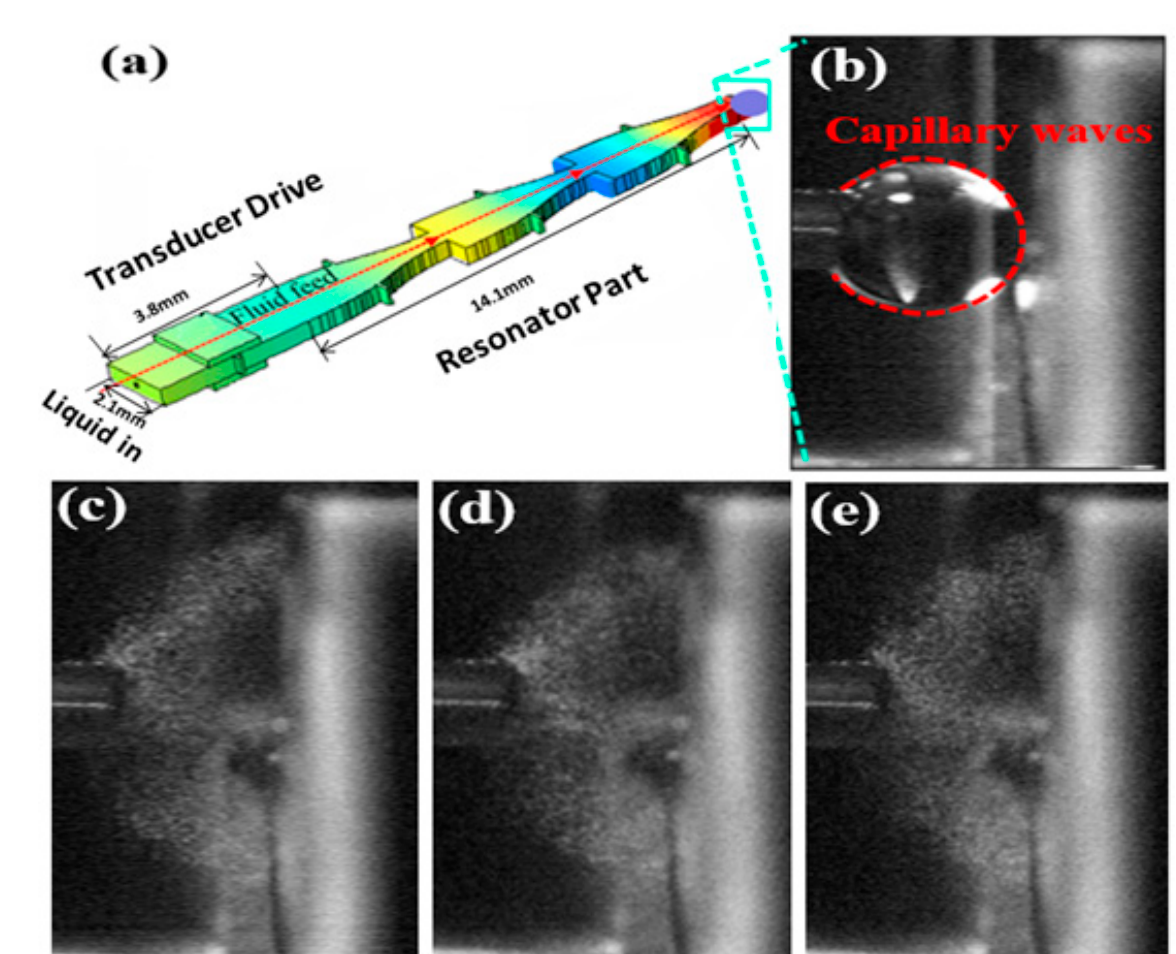
Figure 5. ( a ) Schematic presentation of a silicon-based three-horn ultrasonic nozzle. Optical images obtained from an atomization experiment after voltage was applied for ( b ) 6.49 s, ( c ) 6.50 s ( d ) 43.91 s, and ( e ) 63.59 s. The operating frequency was 484.5 kHz and the applied voltage was 7.9 V under 10 μ L/min liquid flow.